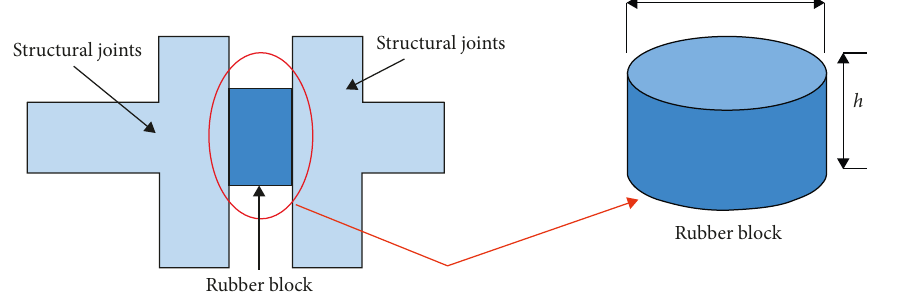
Figure 2: Cylinder polymer block with